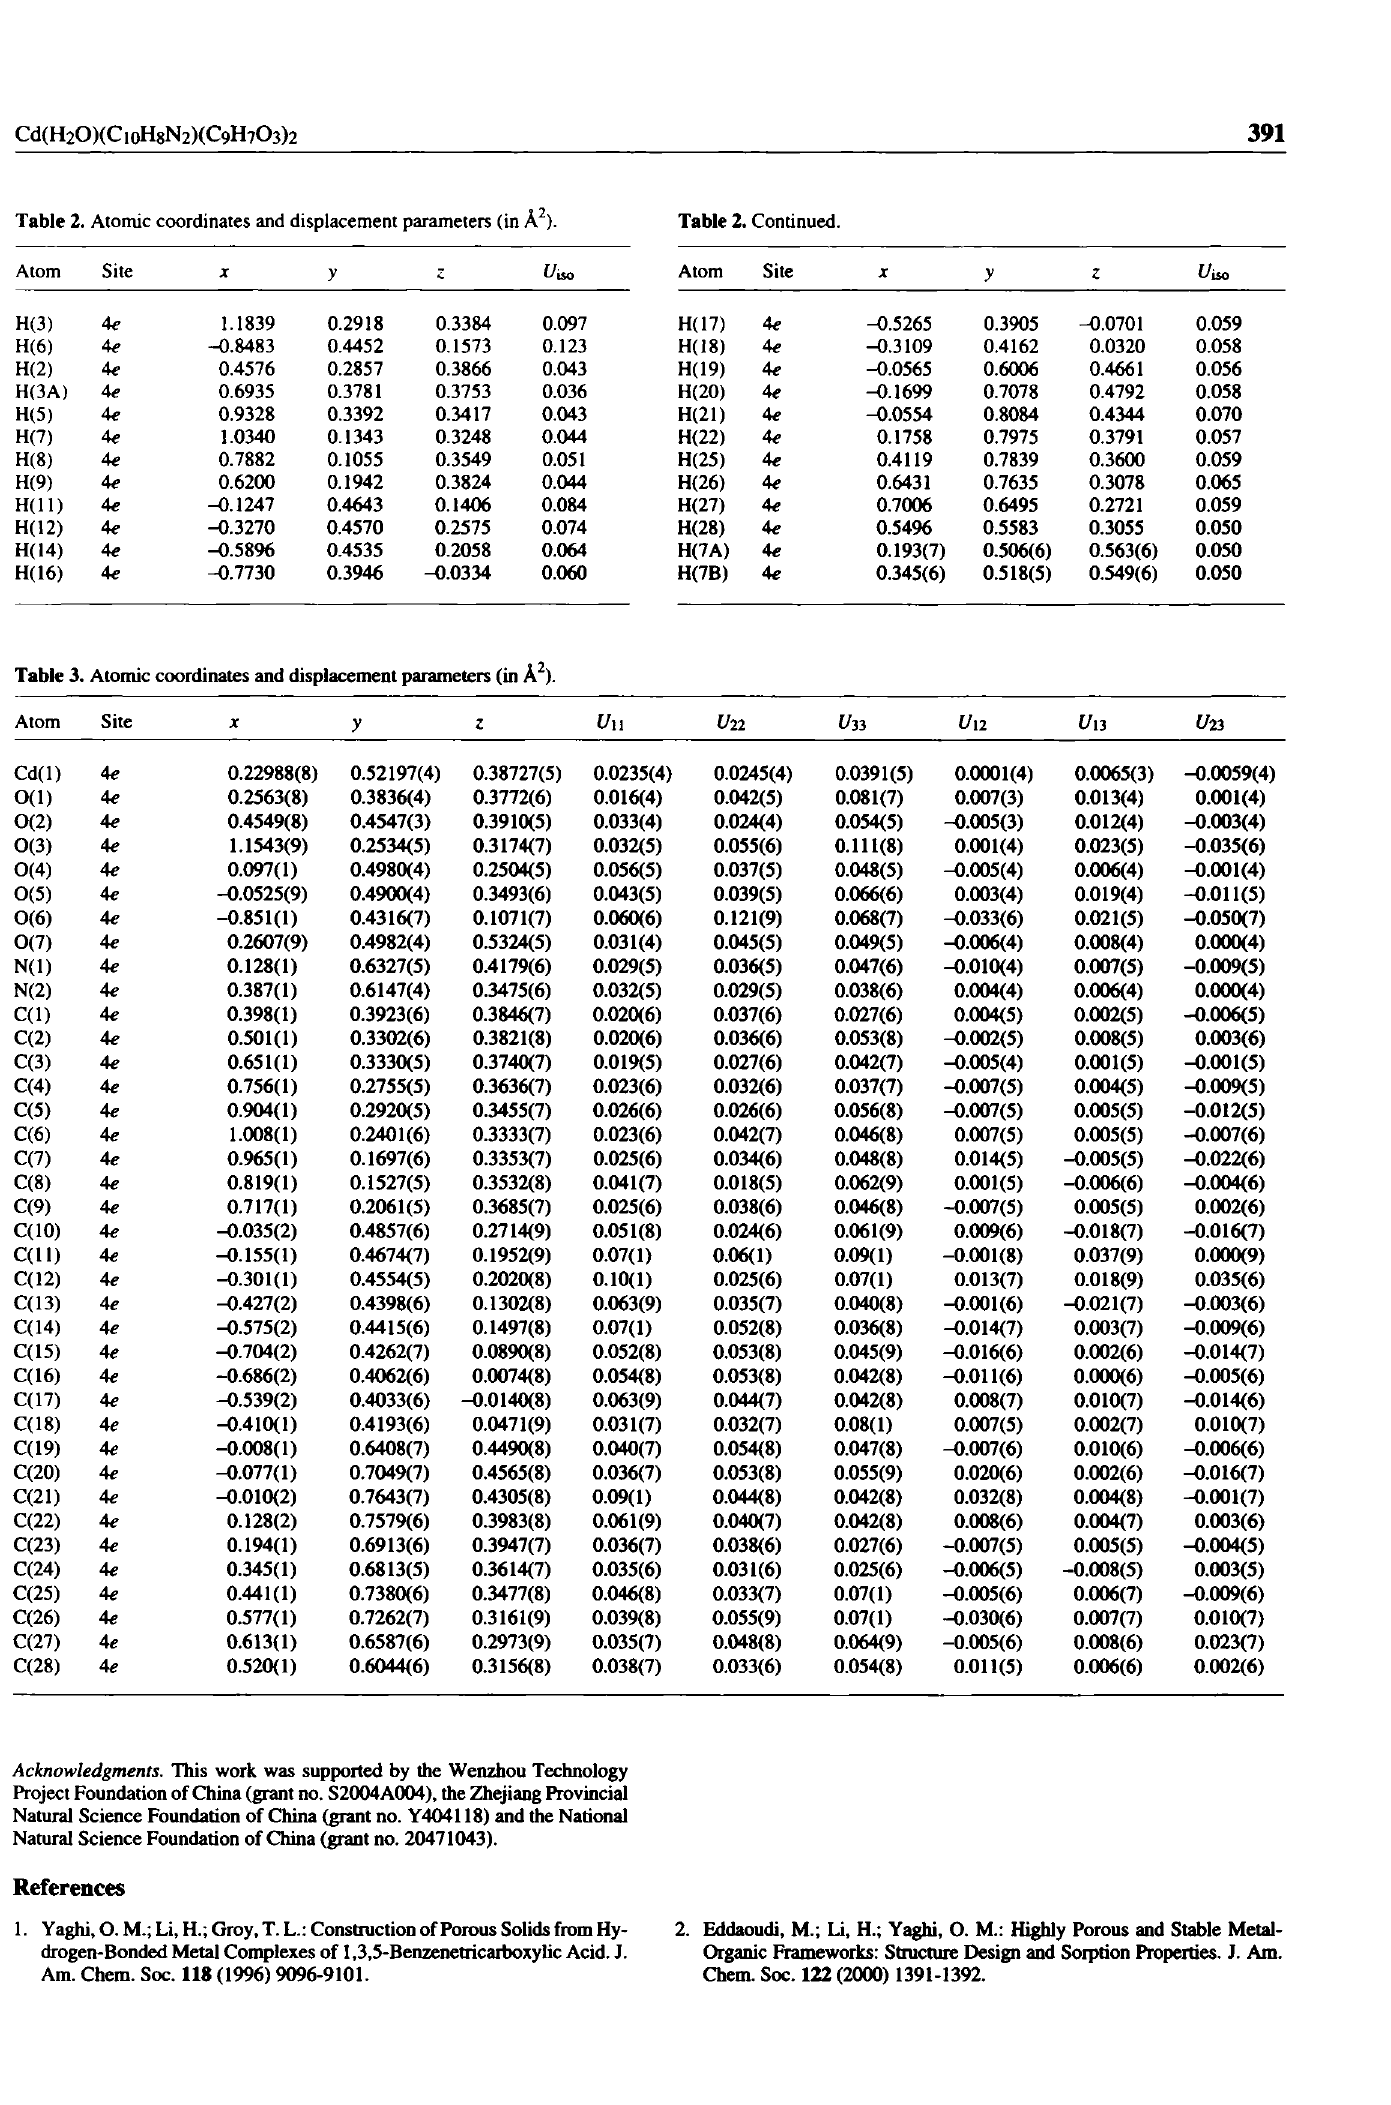
Table 3. Atomic coordinates and displacement parameters (in Ä 2